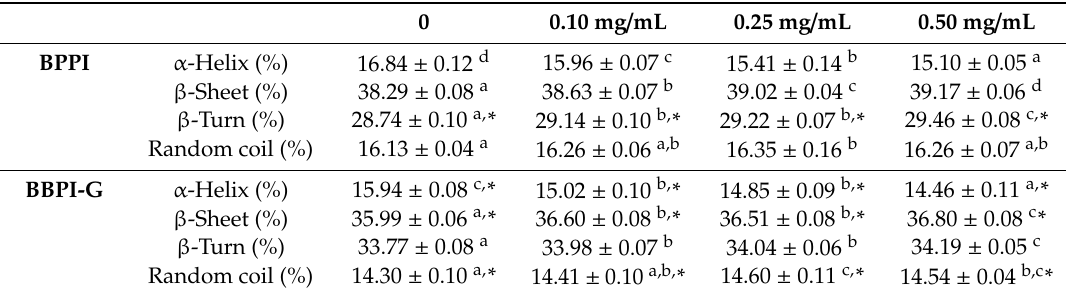
Table 1. Contents of di ff erent secondary structures of BBPI and BBPI-G with di ff erent concentrations of